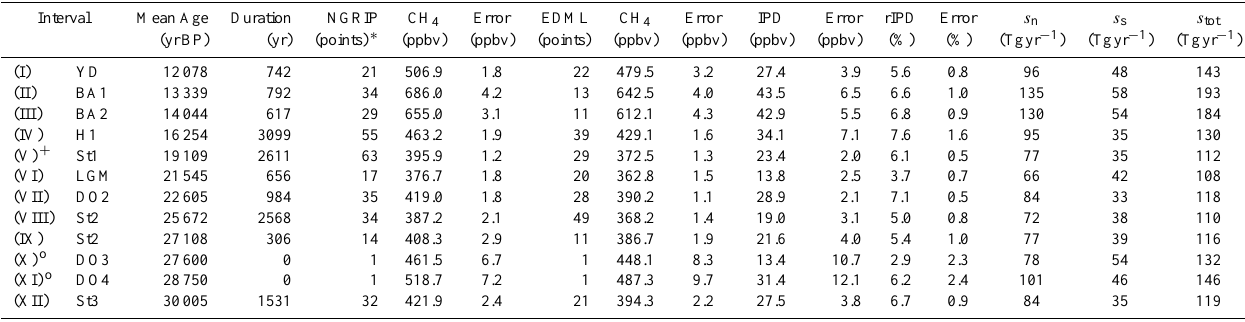
Table 1. List of time intervals where the IPD is calculated (see also Fig. 1). Interval